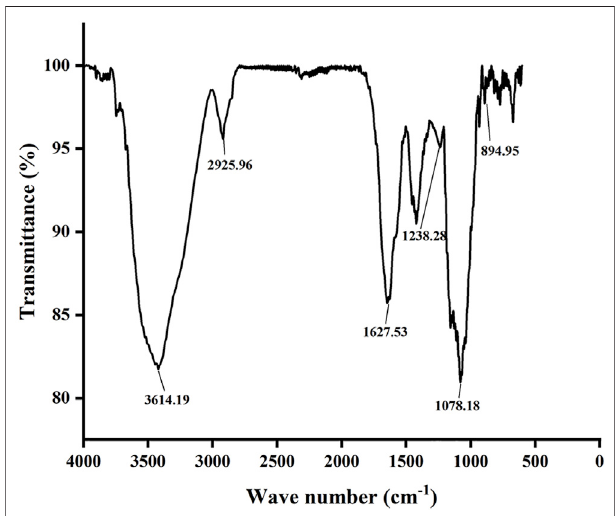
Frontiers in Bioengineering and Biotechnology |